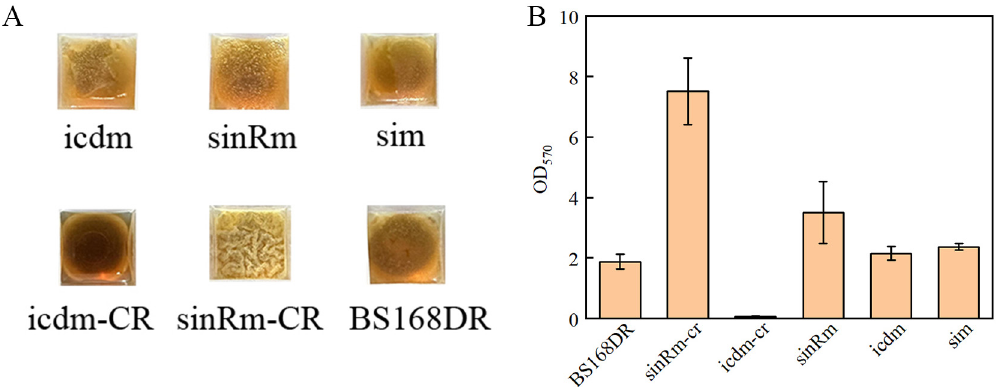
Figure 7. Comparison of bio fi lm morphology ( A ) and bio fi lm biomass ( B ) of BS168DR and engineering strains. The bio fi lm biomass was determined at 48 h of fermentation.